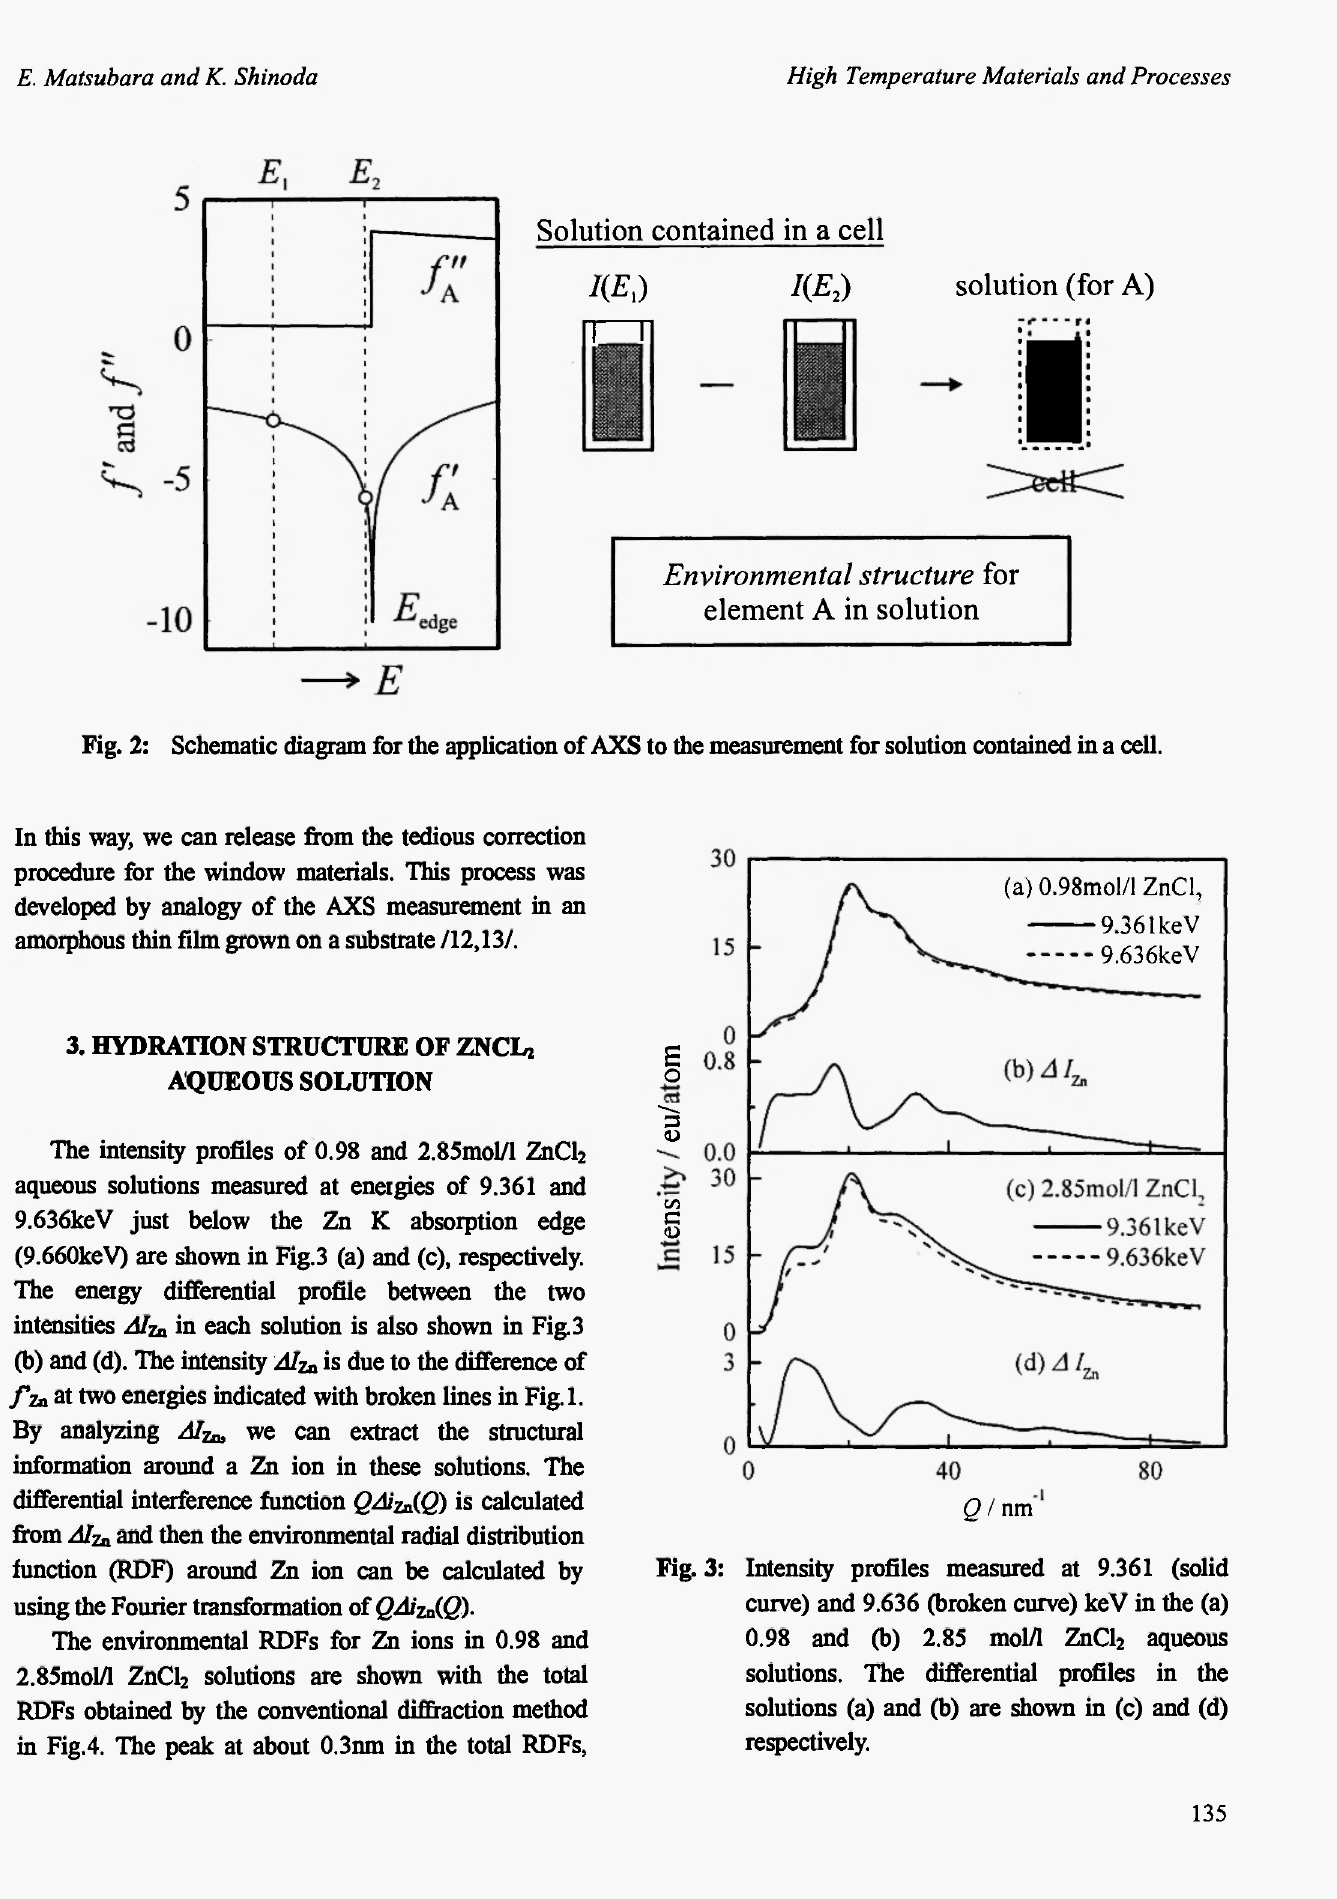
Q / nm Fig.3: Intensity profiles measured at 9.361 (solid curve) and 9.636 (broken curve) keV in the (a) 0.98 and (b) 2.85 mol/1 ZnCl aqueous 2 solutions. The differential profiles in the solutions (a) and (b) are shown in (c) and (d)